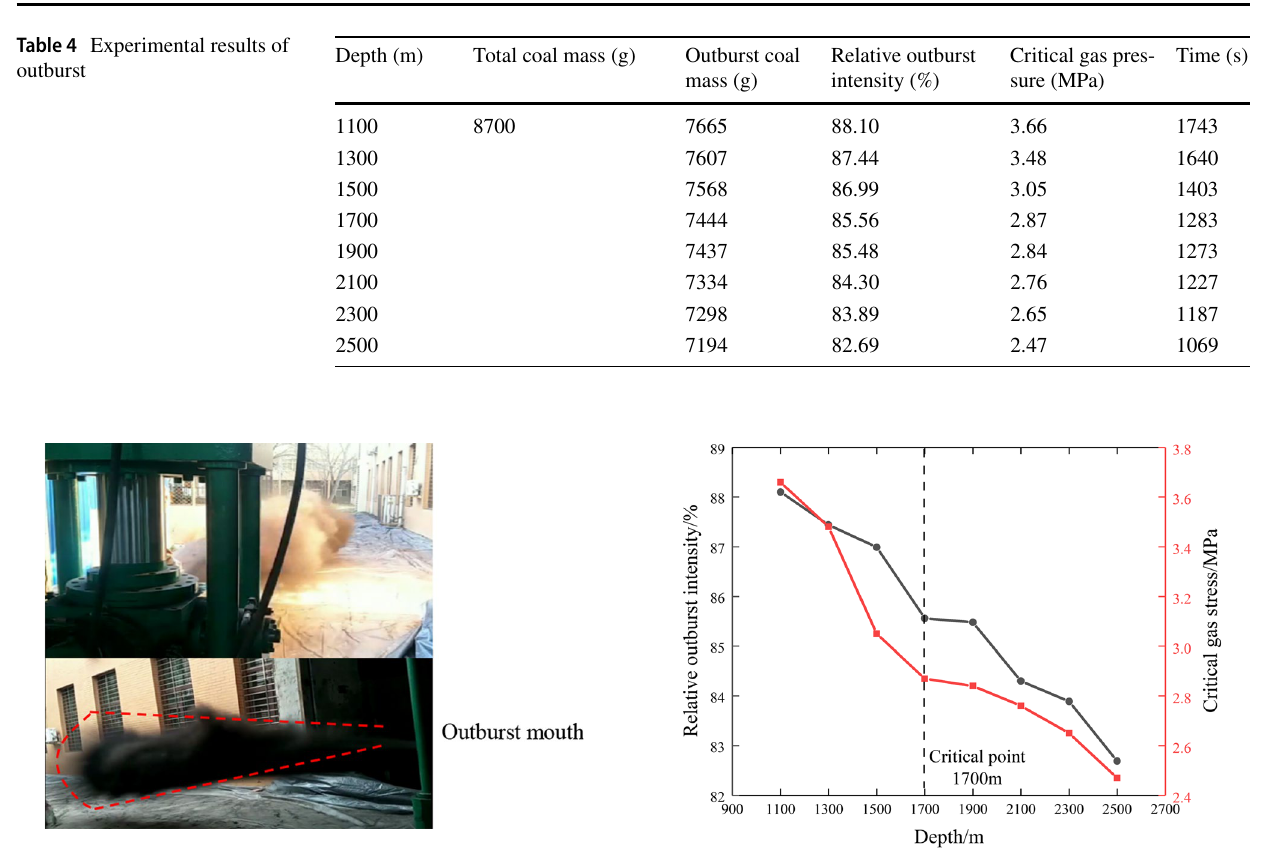
Fig. 2 Similar simulation site of outburst